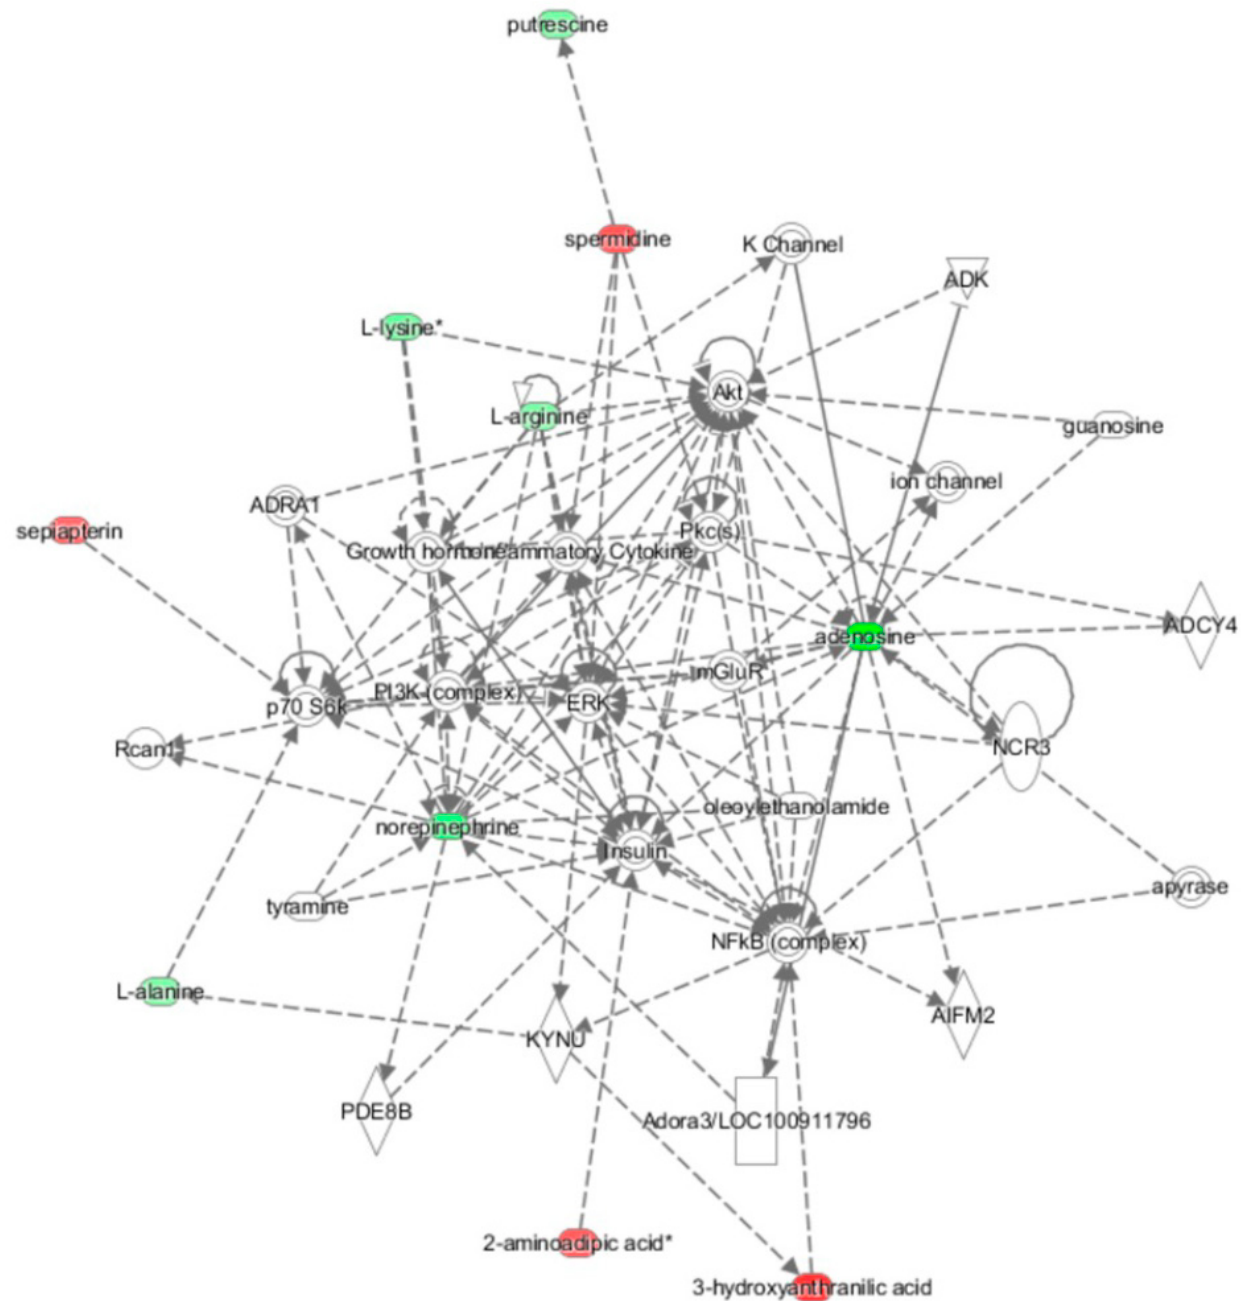
Figure 4. Biological networks “DNA replication, recombination, repair, molecular transport and nucleic acid metabolism” in which significant associations were found between previously identified discriminant metabolites ( p < 0.05) after medium-term intervention with golden berry fruits.